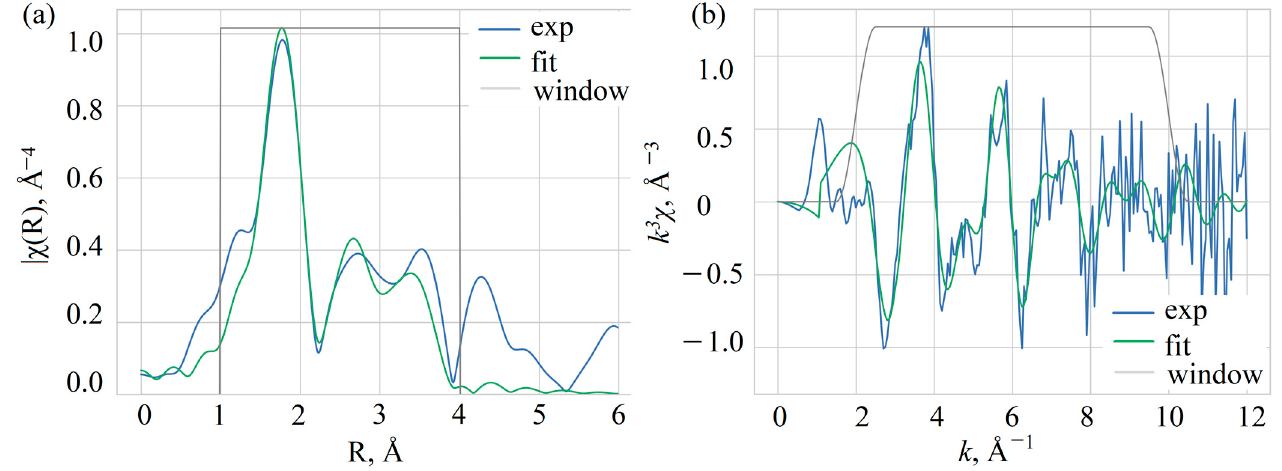
Figure 3. Fourier transform ( a ) and the oscillating part ( b ) of the EXAFS spectrum of Mn in YAB:Mn.